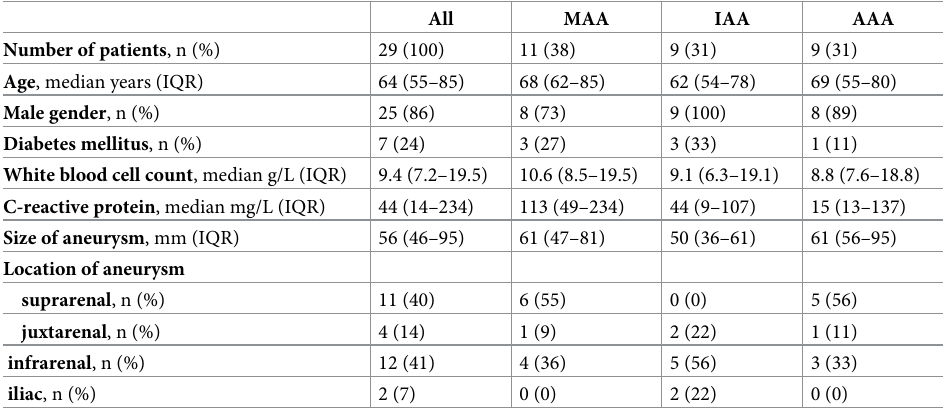
Table 1. Baseline